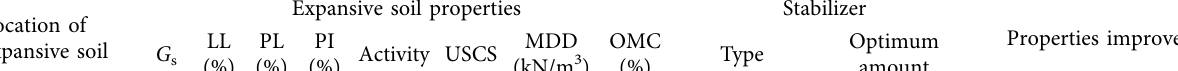
Table 5: A succinct list of research conducted on Ca-based stabilizer materials for different expansive soils across the world. Location of expansive